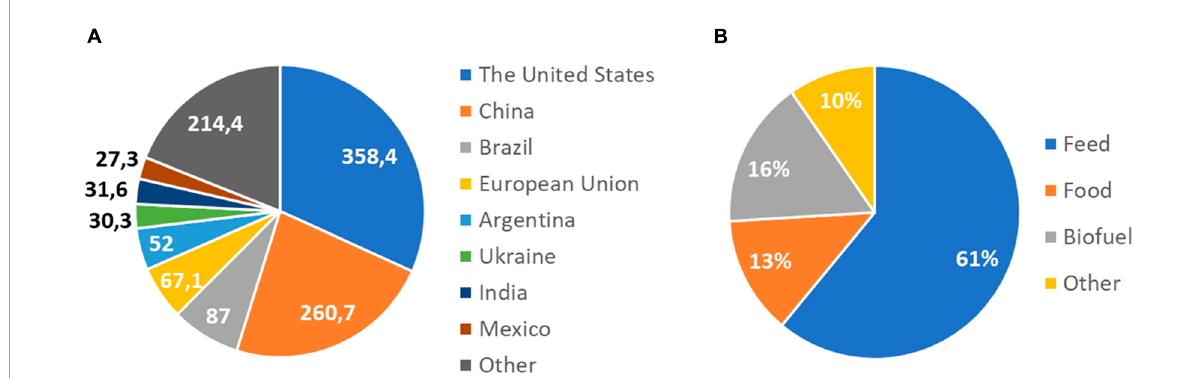
FIGURE1 World maize production and uses. (A) Maize production by country in 2020/2021. The United States, China, and Brazil are the top producers. Production is expressed in million metric tons. Data source: USDA, Foreign Agricultural Service, Global Market Analysis. (B) Global uses of maize in 2021. Maize is used as food and animal feed, and as a source of biofuel. It can also be processed into a wide range of useful chemicals. Data source: OECD/FAO, 2021;